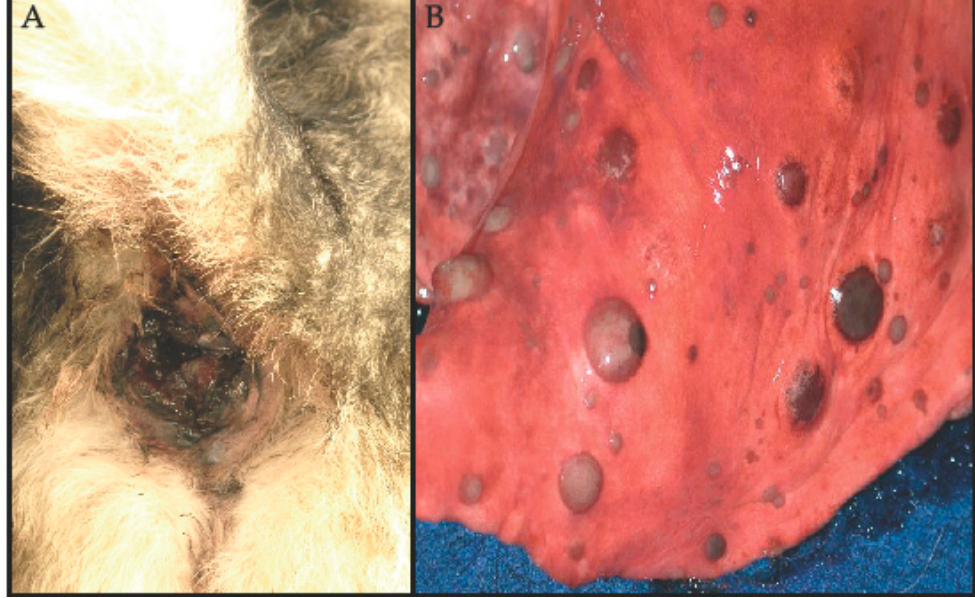
Figure 1. Clinicopathological manifestations of mucosal melanoma in dogs. ( A ) Canine mucosal melanoma involving the anorectal area of a dog. There is a darkly pigmented (melanized) mass involving the mucous membranes of the anus. ( B ) Pulmonary metastasis of a mucosal melanoma. Circumscribed nodular metastatic lesions with varying degrees of melanin pigmentation are disseminated in the lung parenchyma, visible at the visceral pleura, of an autopsy specimen (different dog from image in ( A )). Lesion photographs were kindly provided by Dr. Jeff Caswell, Department of Pathobiology, Ontario Veterinary College, University of Guelph, Guelph, Ontario,